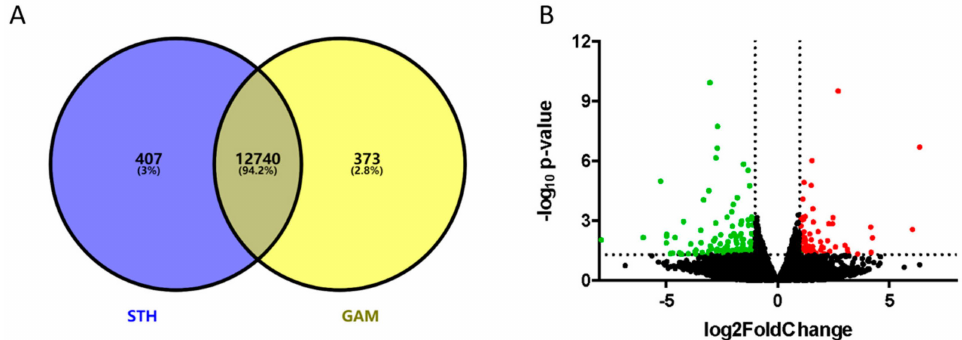
Figure 2. Di ff erentially expressed gene distributions during lactation in the mammary gland of the Small-Tail Han (STH) and Gansu Alpine Merino (GAM) sheep. ( A ) Venn diagram summarizing the number of genes expressed only in the STH sheep, expressed only in the GAM sheep, and common to both groups. ( B ) Volcano plot comparing the change in gene expression of the STH and GAM sheep. The red and green dots indicate upregulated and downregulated genes in mammary gland of STH compared to the mammary gland of GAM, respectively ( p < 0.05). The black dots represent genes that are not significantly di ff erent in the two breeds of sheep ( p >